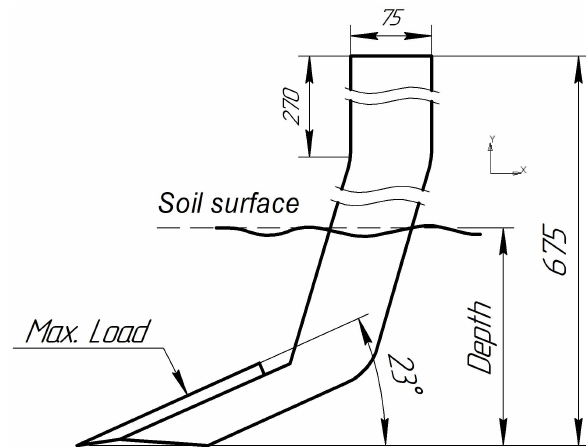
Figure 8: The overall view of boundary